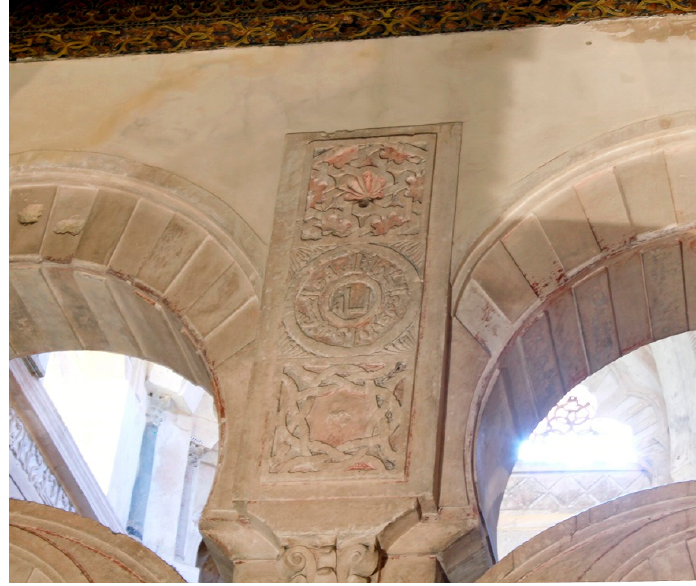
Figure 18. Great Mosque of Cordoba. Circular inscription located on the west bay of the maq ṣ ū ra. © Photo took by author.